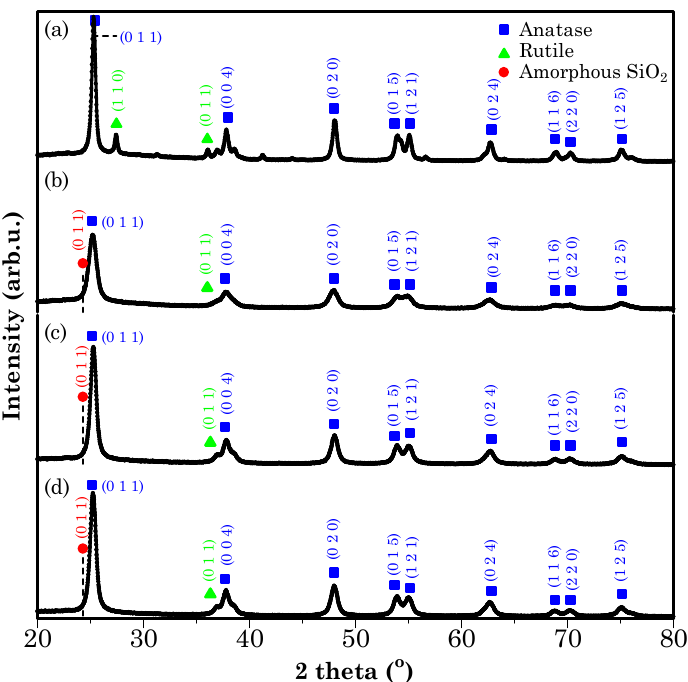
Figure 1. X-ray di ff raction (XRD) pattern of ( a ) TiO 2 P25; ( b ) TiO 2 / SiO 2 (1:1) composite; ( c ) TiO 2 / SiO 2 Figure 1. X-ray diffraction (XRD) pattern of ( a ) TiO 2 P25; ( b ) TiO 2 /SiO 2 (1:1) composite; ( c ) TiO 2 /SiO 2 (3:1) composite and; ( d ) TiO 2 / SiO 2 (7:1) composite. (3:1) composite and; ( d ) TiO 2 /SiO 2 (7:1) composite.